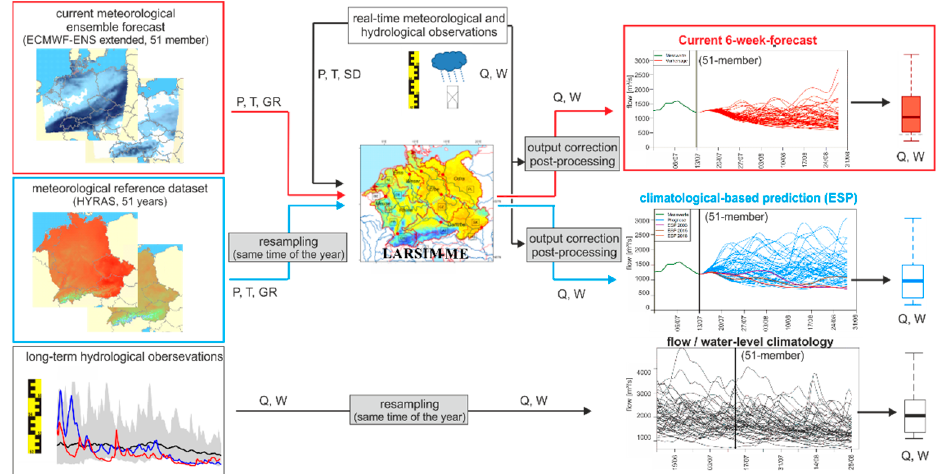
Figure 3. Schematic overview of the workflow for the 6-week forecast, and the three different outputs displayed in the forecast product.